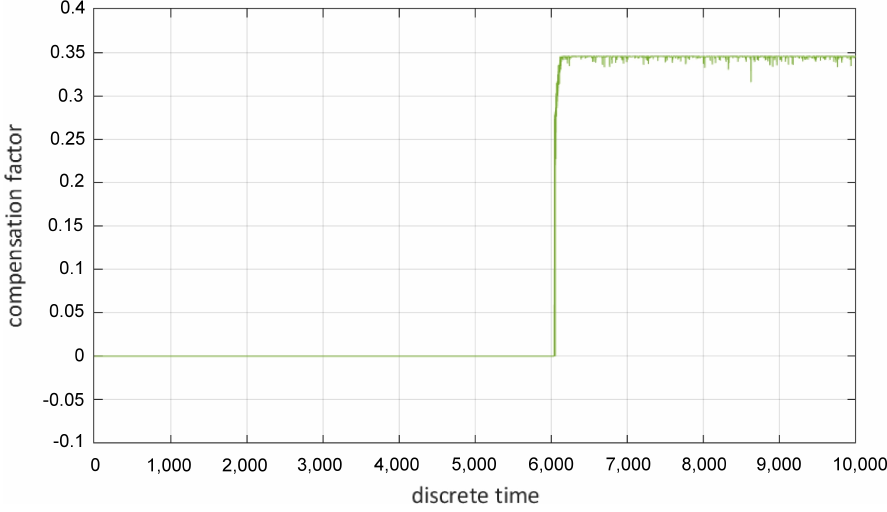
Figure 8. Compensation factor generated with the fuzzy virtual